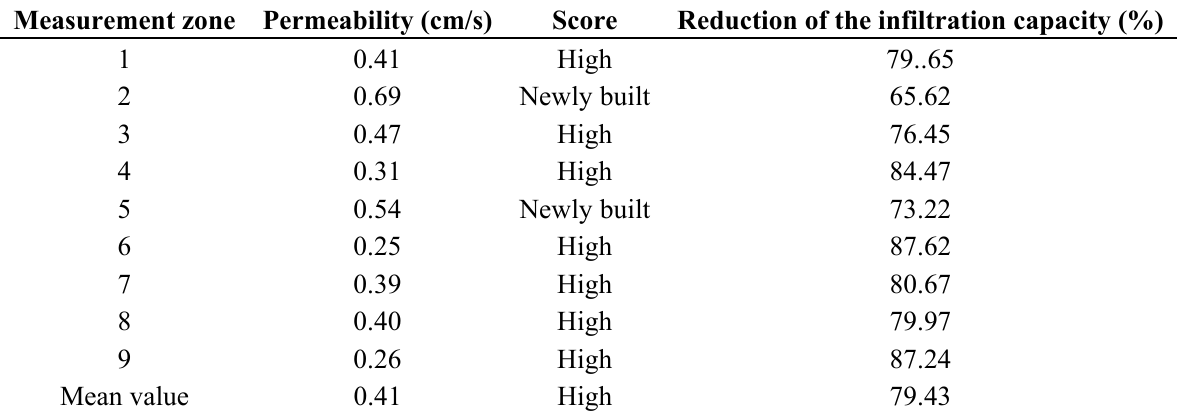
Table 2. Average permeability and reduction of the infiltration capacity values registered in each measurement zone within each Polymer Modified Porous Concrete (PMPC) surface car park and their corresponding